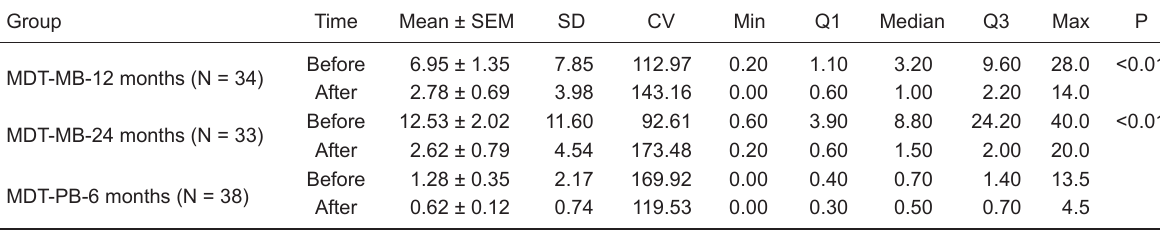
Table 1 . Anti-PGL-1 levels of patients with leprosy before and after treatment.